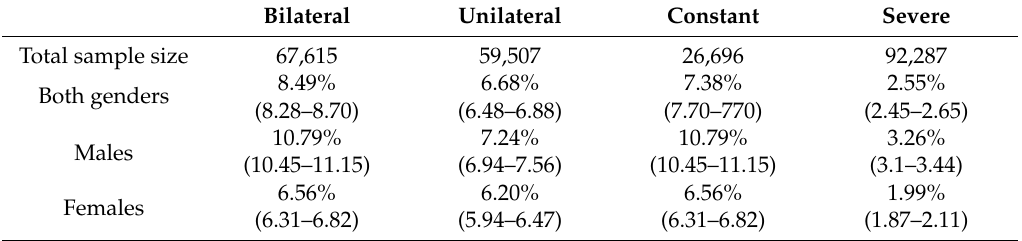
Table 1. Prevalence table of tinnitus subtypes according to sex. 95% confidence intervals (CI) are shown between parentheses. The sample sizes for unilateral and constant tinnitus are reduced due to an age-matching procedure. This procedure ensures that the average age of the population and that of the family members in STOP do not di ff er substantially (see Supplementary Materials 1 for